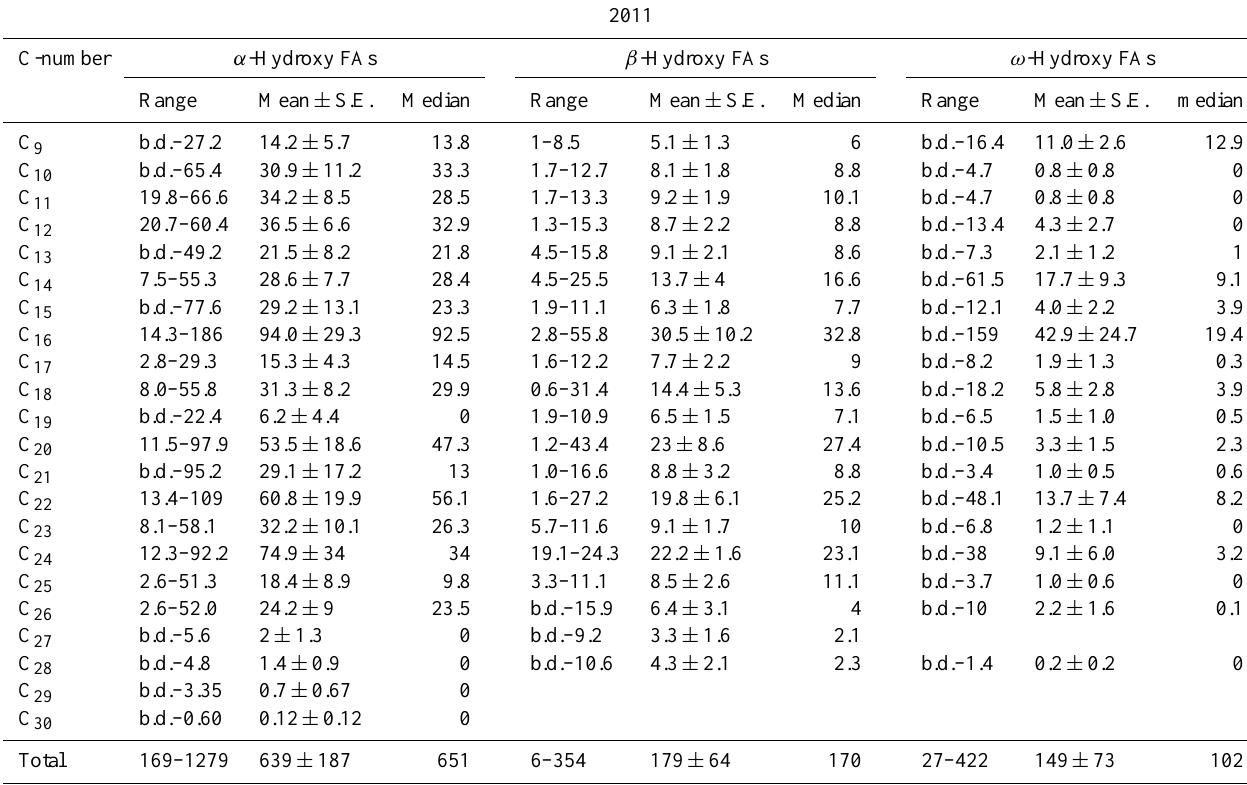
Table 2. Mass concentrations (in ng kg − 1 ) of α -, β - and ω -hydroxy fatty acids (FAs) measured in snow samples ( N = 6) collected from Sapporo during the winter of